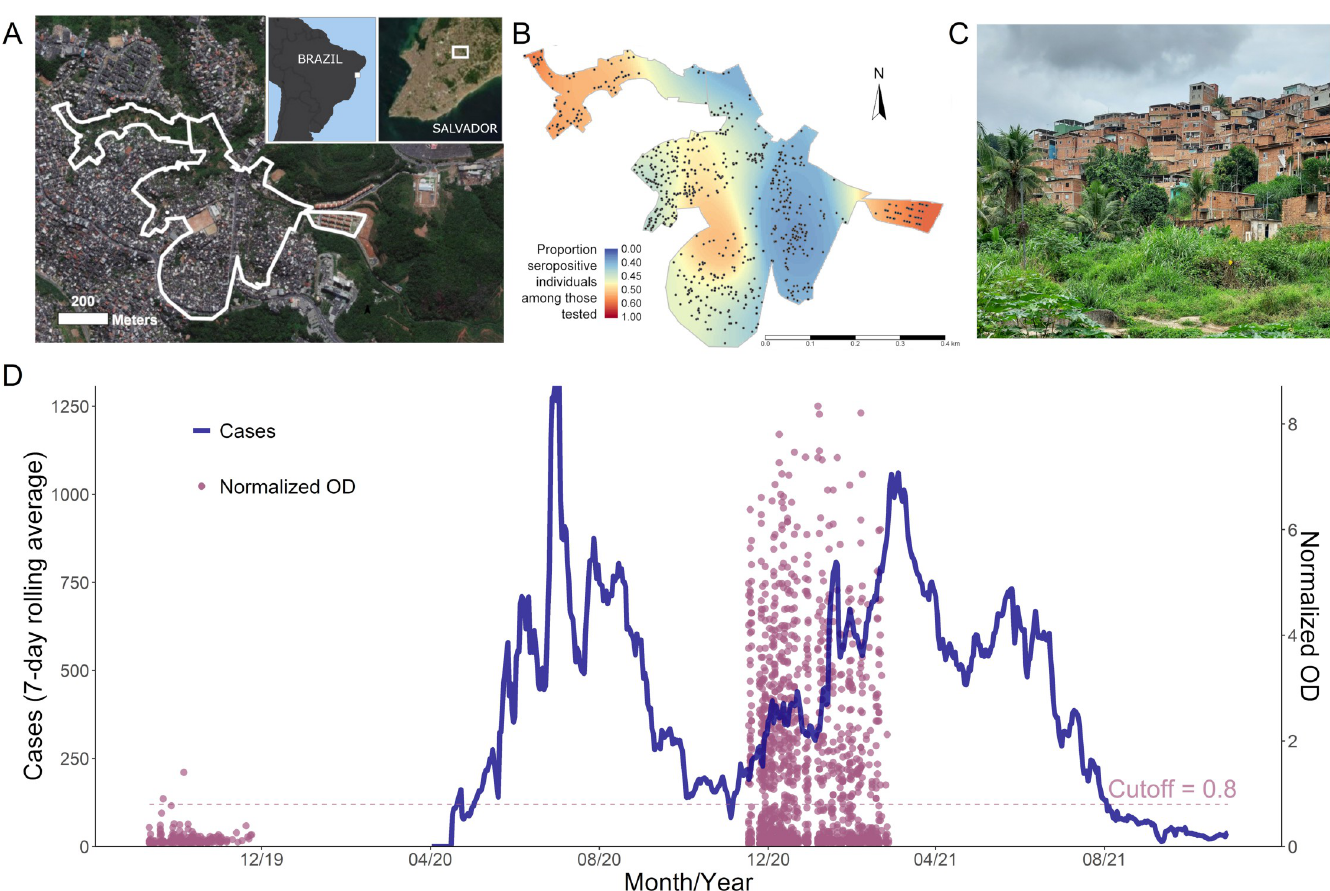
Fig 1. Study population and context. Panel (A) shows an aerial image of the study area, with insets depicting the location of the study area within Brazil and Salvador. Panel (B) depicts the location of participating households. The choropleth reflects the spatial distribution of seropositivity within the study area. Panel (C) is a representative photo of the study area. (D) Confirmed cases of COVID-19 in Salvador, Brazil, up to October 2021 (blue). Overlaid over the epidemiologic curve, in purple, are the normalized OD values of serological samples collected from cohort participants prior to the pandemic (September 11 to November 24, 2019) and after the first wave of the pandemic (November 17, 2020 to February 26, 2021). The map in panel (A) was created using ArcGIS software by ESRI. Source: ESRI, Maxar, GeoEye, Earthstar Geographics, CNES/Airbus DS, USDA, USGS, AeroGRID, IGN, HERE, Garmin, OpenStreetMap contributors, and the GIS User Community. Base layers: https://services.arcgisonline.com/ArcGIS/rest/services/World_Imagery/MapServer, https://services.arcgisonline.com/arcgis/rest/services/Canvas/World_Dark_Gray_ Base/MapServer. COVID-19, Coronavirus Disease 2019; OD, optical density.